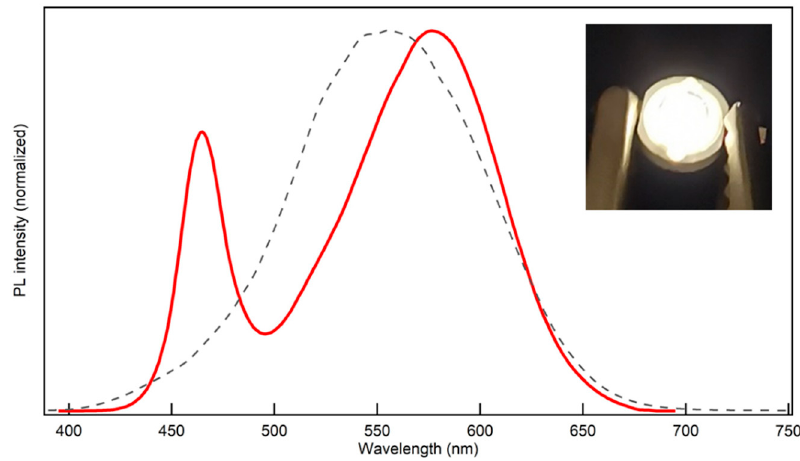
Figure 4. The emissive spectrum of WLED based on InP/ZnS/ZnS QDs, the inset shows the white light emission of the WLED.